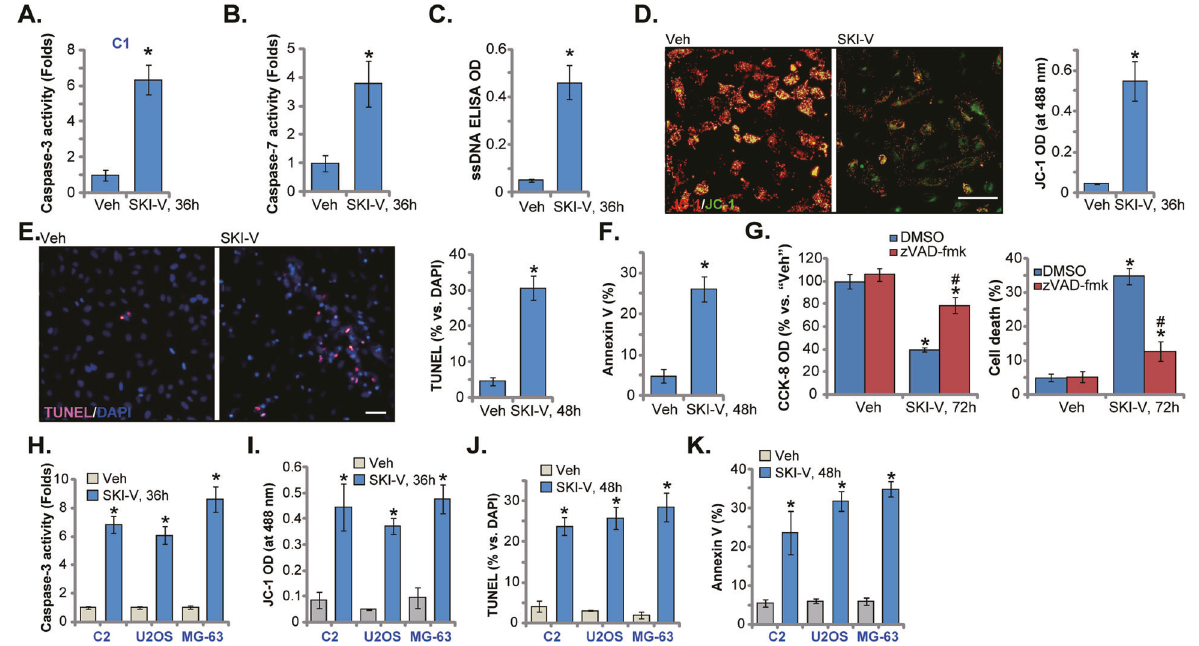
Fig. 2 Apoptosis activation in SKI-V-treated OS cells. The primary human OS cells ( “ C1 ” / “ C2 ” , A – F , H – K ) or the immortalized cell lines (U2OS and MG-63, H – K ) were cultured in FBS-containing compete medium and treated with SKI-V (at 25 μ M) for applied time periods; The relative caspase-3 and caspase-7 activities ( A , B and H ), single strand DNA contents (ELISA OD, C ), mitochondrial depolarization (JC-1 staining assays, D and I ) were tested; Cell apoptosis was tested by nuclear TUNEL staining ( E and J ) and Annexin V-PI FACS ( F and K ) assays, with results quanti fi ed. The C1 primary OS cells were pretreated with the pan caspase inhibitor z-VAD-fmk (50 μ M) or 0.25% DMSO for 30 min, followed by SKI-V (at 25 μ M) treatment for 72 h, cell viability and death were examined by CCK-8 and Trypan blue staining assays, respectively ( G ). “ Veh ” stands for the vehicle control. Data were presented as mean ± standard deviation (SD, n = 5). * P < 0.05 vs. “ Veh ” group. # P < 0.05 vs. DMSO group ( G ). Experiments were repeated fi ve times with similar results obtained. Scale bar = 100 μ m ( D and E